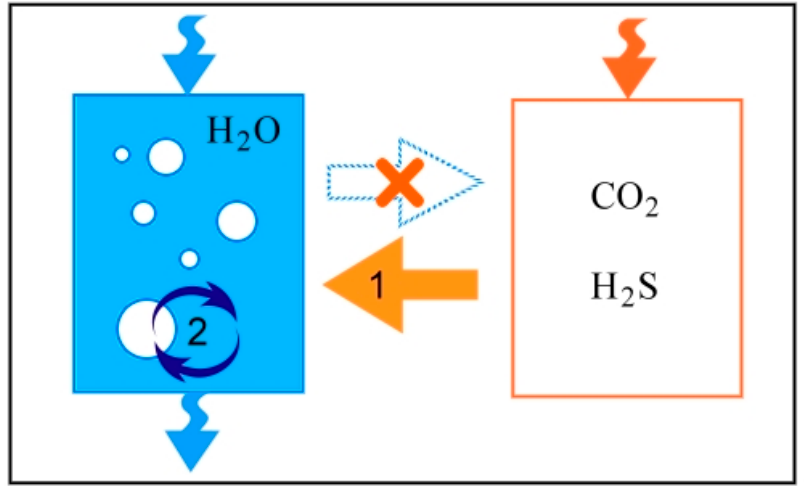
Figure 2. Phase interactions between gas and liquid in the reinjection point.